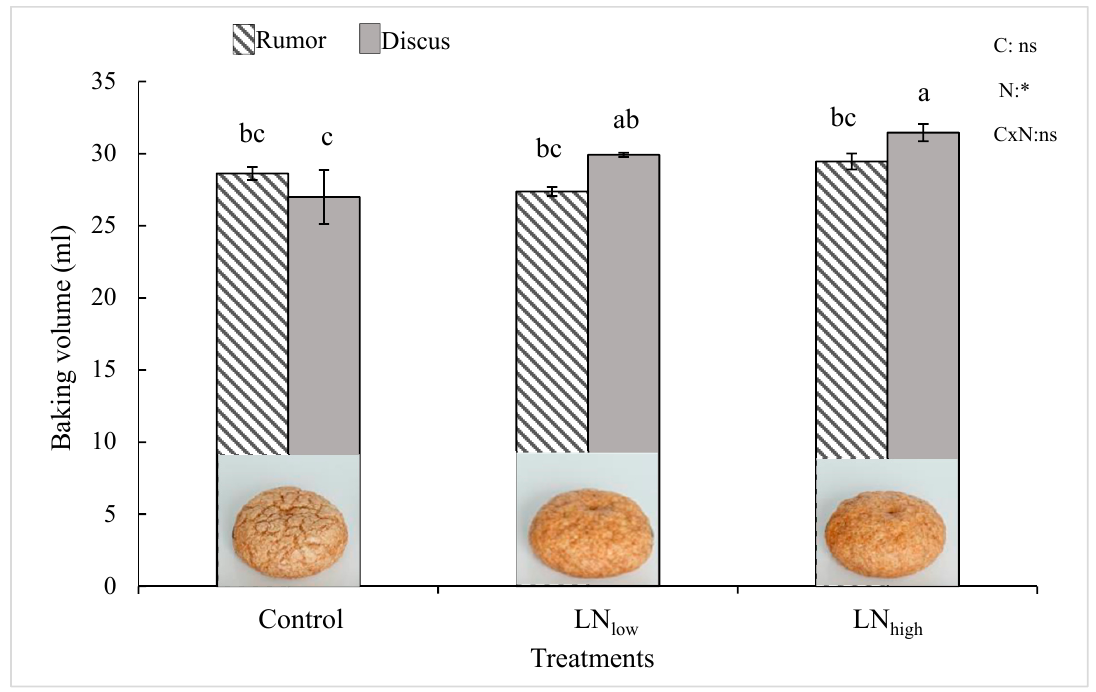
Figure 4. Baking volume [ml] in response to late N fertilization (Control, LN low , LN high ) for the two cultivars Rumor and Discus. Bars represent mean values ± SE ( n = 3). Different small letters indicate significant differences between all treatment combinations ( p ≤ 0.05). Two-way ANOVA results are shown in the upper right corner. C: cultivar; N: different fertilizer treatment; CxN: Interaction between cultivar and different fertilizer treatment. ns: not significant; *: significant effect. Representative pictures of mini-loaf produced by the micro baking test for Discus are shown at the bottom of the graph.